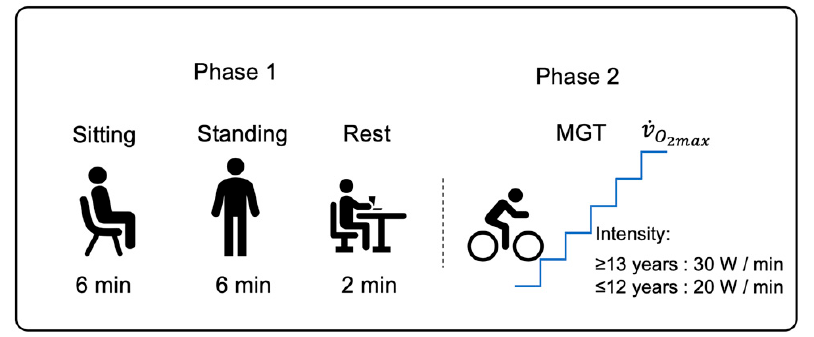
. VO 2max : maximal oxygen